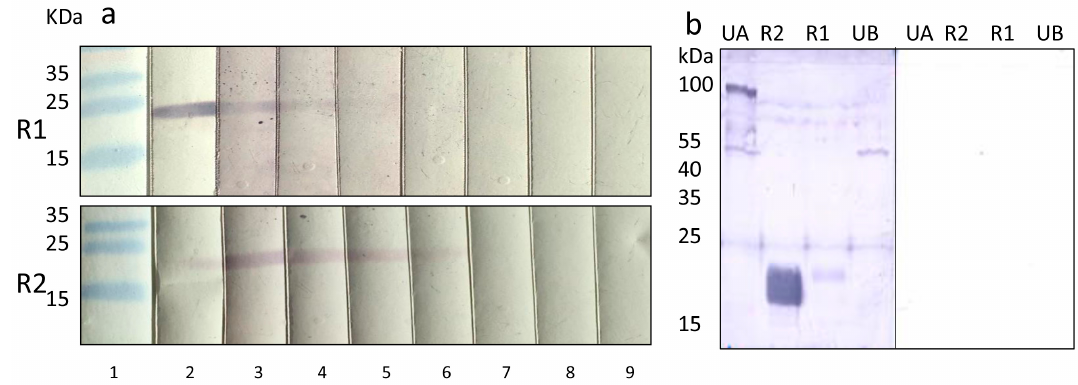
Figure 4. ( a ) Strong reaction of a Cytotect preparation against the recombinant gB proteins R1 and R2